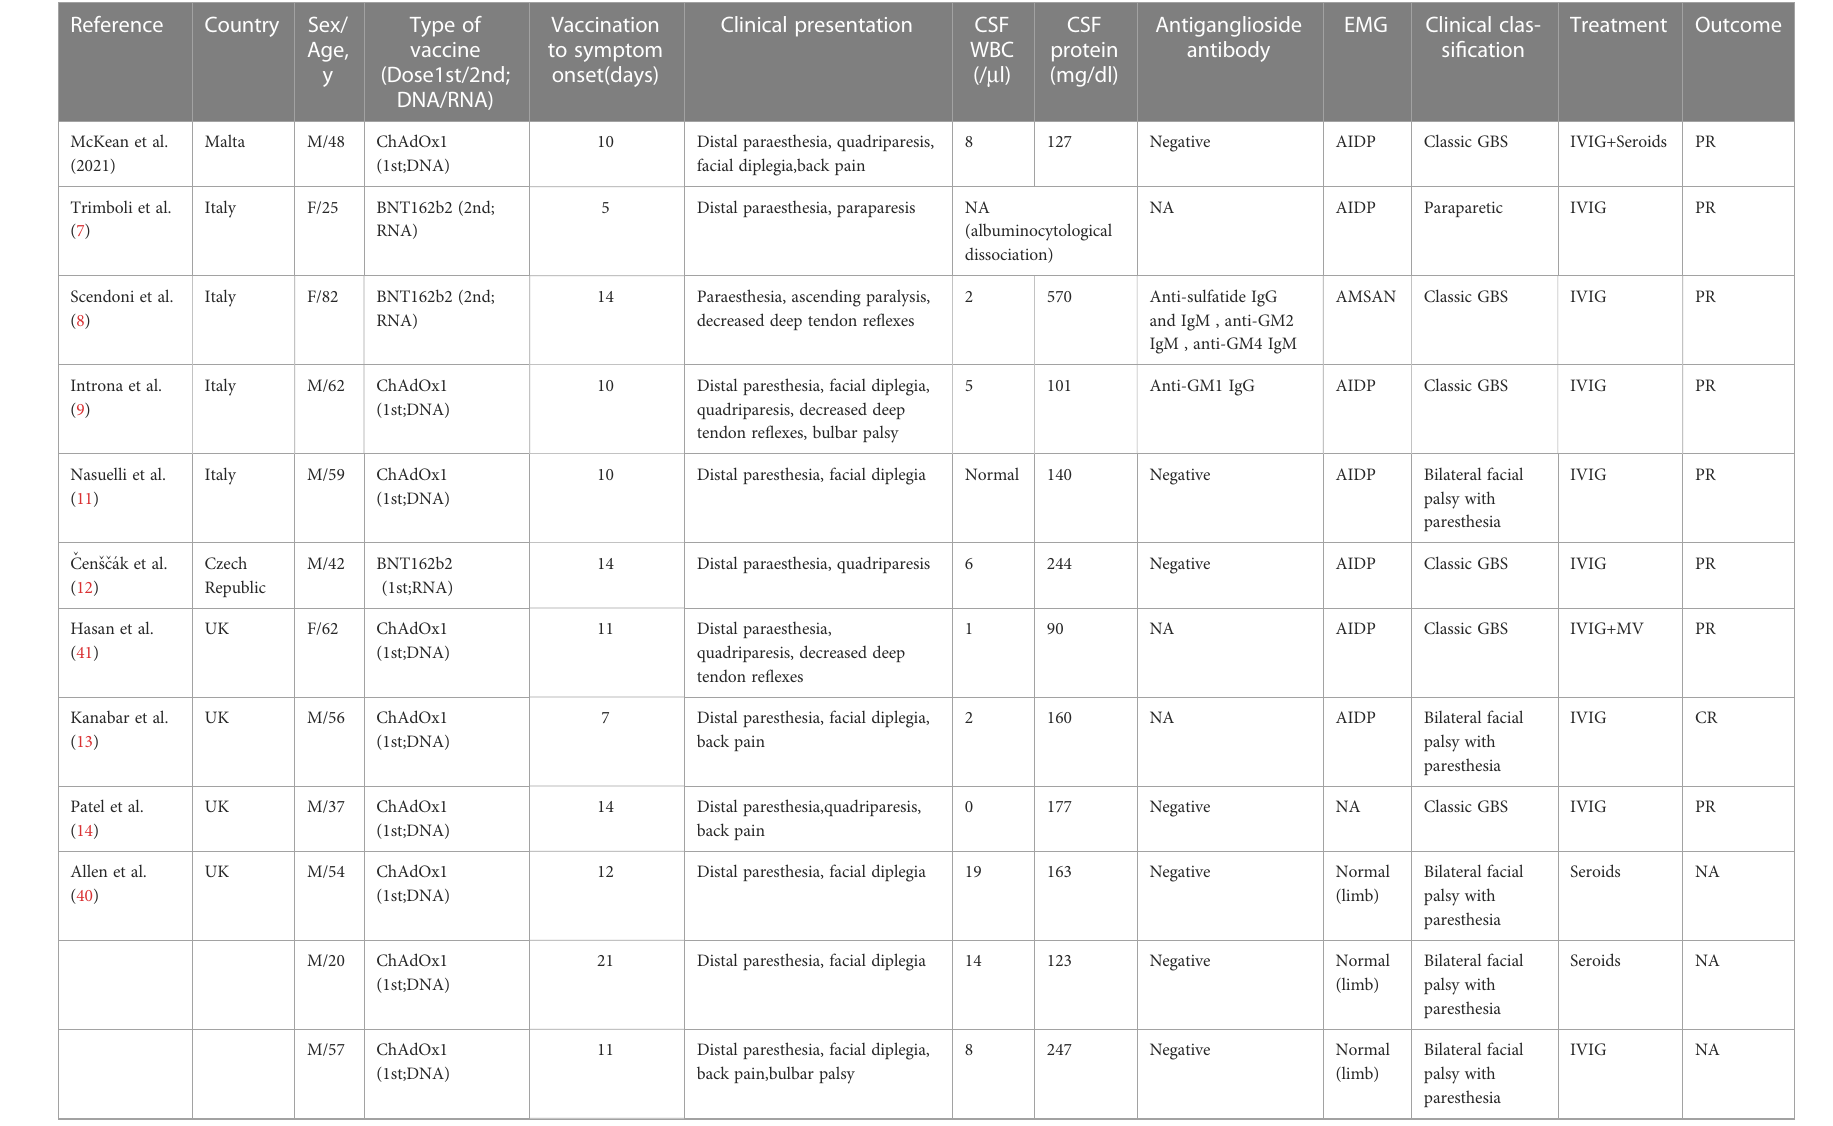
TABLE 1 Case reports of patients with GBS who associated with COVID-19